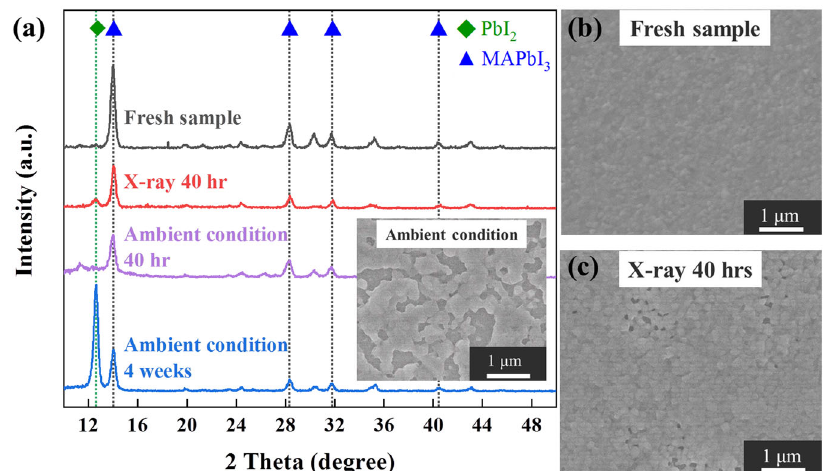
Fig. 1 Crystallinity and surface morphology of perovskite fi lms. a XRD patterns of perovskite fi lms with different storage conditions. The inset SEM image in Fig. 1a is the specimen under ambient conditions for 4 weeks. SEM images of the sample treated with b 0-h and c 40-h X- ray